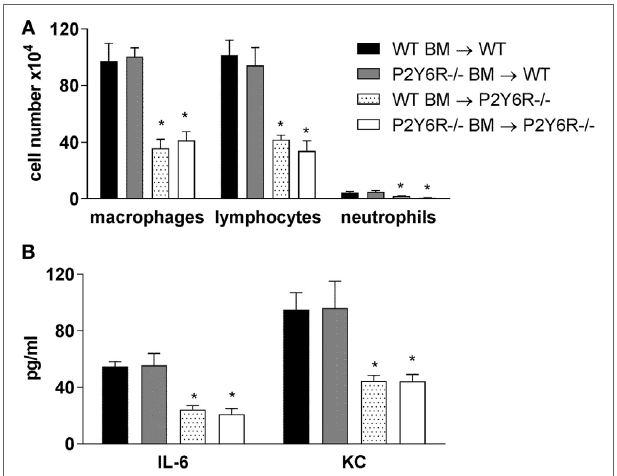
FigUre 5 | Involvement of P2Y 6 R subtypes on inflammatory and lung structural cells in bleomycin-induced pulmonary fibrosis. The indicated chimeric animals were generated. Mice received an intratracheal application of BLM on day 0. Bronchoalveolar lavage total and differential cell counts were performed, (a) and cytokine concentrations were measured by ELISA (B) at day 14. n = 5–8 per group. * p < 0.05 compared to WT BM → WT or to P2Y 6 R − / − BM →